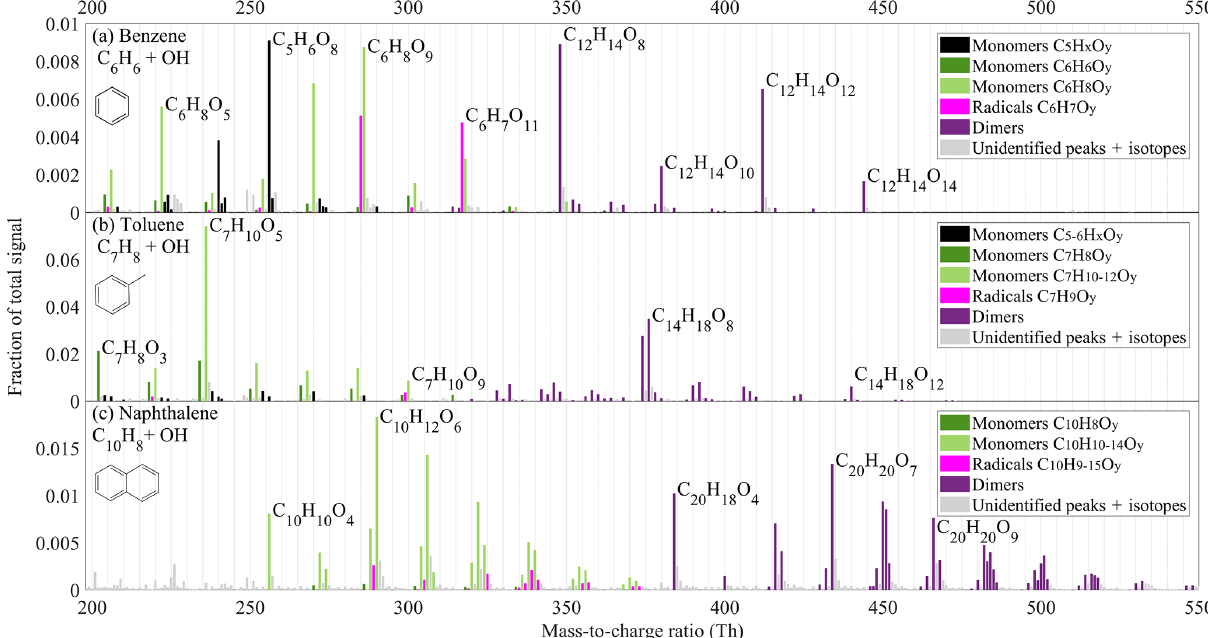
Figure 3. Spectra of organic oxidation products observed in oxidation of (a) benzene, (b) toluene and (c) naphthalene. The y axis shows the signal normalised by the total ion count of the instrument. The colours indicate different compound groups, as described in the legend of each subplot. The unit masses with more than one peak are marked with the colour of the most abundant peak. All the peaks above 200 Th are detected as adducts with NO − , which is excluded from the labels. The full list of peaks can be found in the Supplement (Tables S1–S3). 3 Unidentified masses, isotopes, and contaminant peaks are marked in light